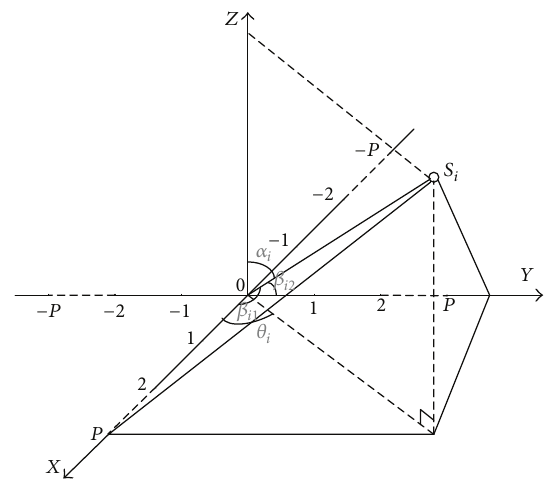
Figure 1: Sensor-source configuration for the near-field